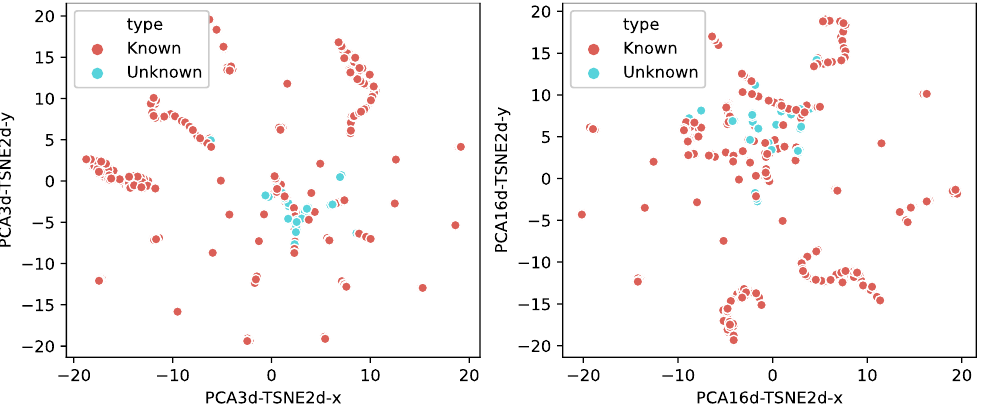
Figure 8. Visualization of the probability vectors from the multi-classifier. Table 4. Performance of the classifiers in distinguishing between the known and unknown